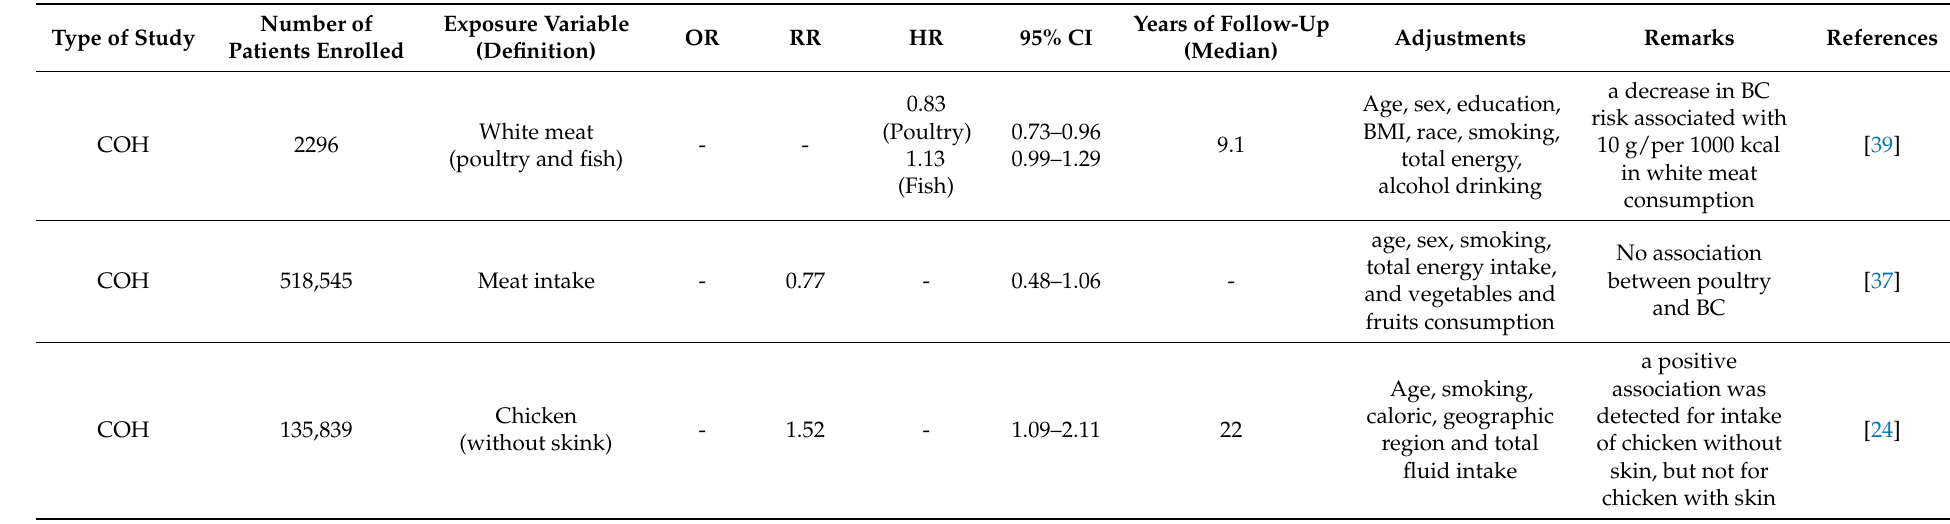
Table 2. Characteristics of studies that analyzed white meat consumption and bladder